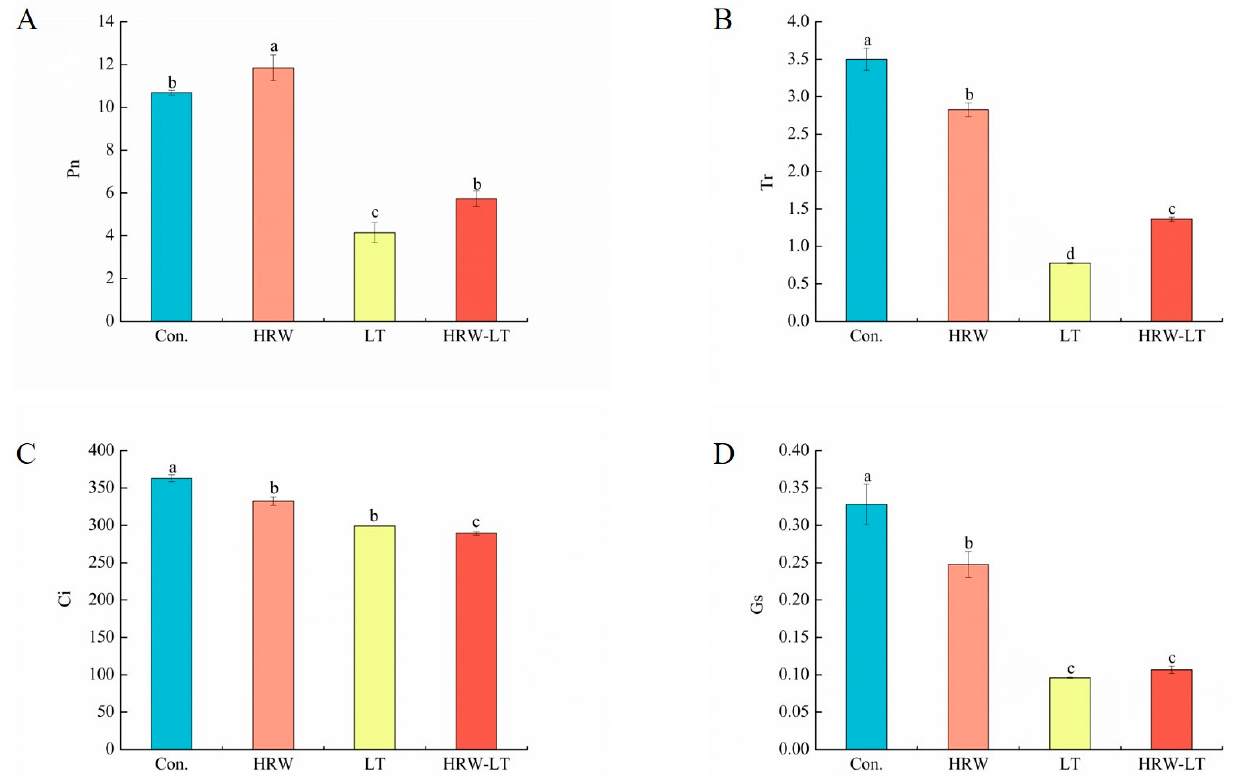
Figure 5. After HRW treatment, the effect of gas exchange parameters of cucumber seedlings under chilling stress. ( A ) Pn; ( B ) Tr; ( C ) Ci; ( D ) Gs. Data are the mean ± standard deviation of three biological replicates. The different letters indicate a significant difference ( p < 0.05). These indicators were measured after 72 h of chilling stress.